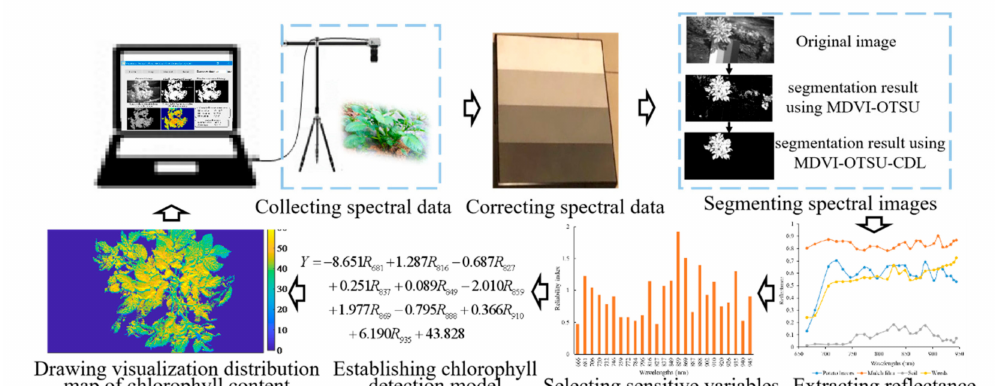
Figure 1. Schematic illustration of the main data processing